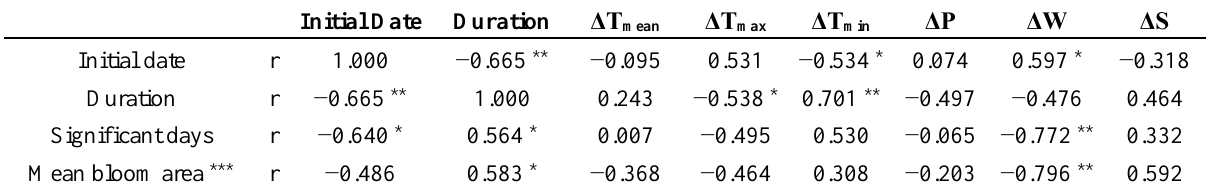
maxima (solid circles in Figure 2) can represent the monthly bloom conditions after interference from the wind mixing is